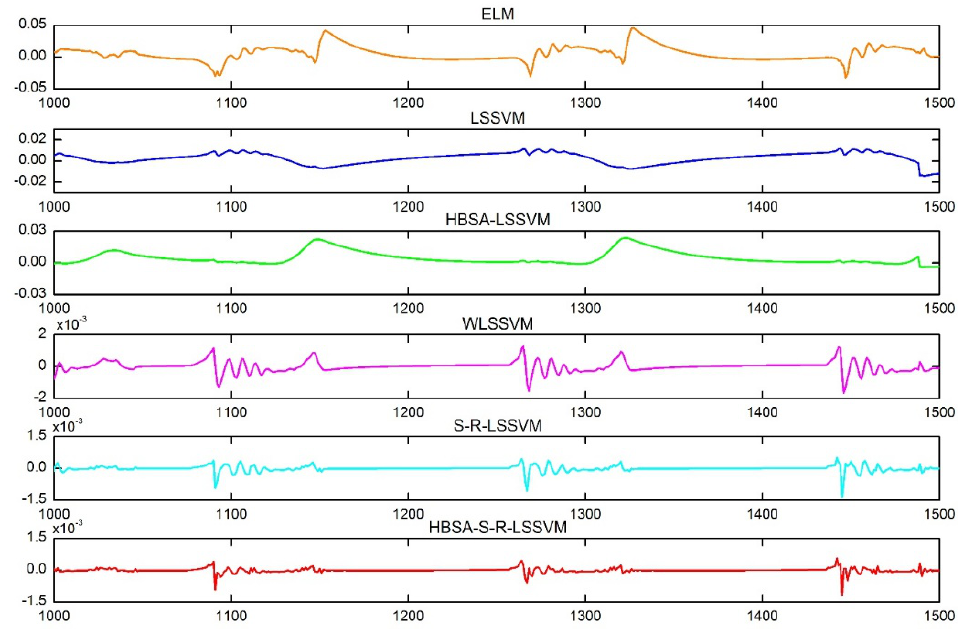
Figure 11. Predicted residuals for each identification model under Scheme A.